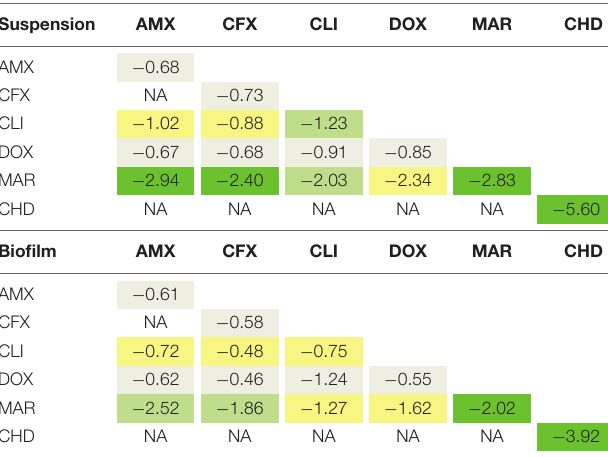
TABLE 2 | Bacterial reductions of S. aureus suspension (in log 10 CFU/mL) and biofilm (in log 10 CFU) after 15-h exposure to one drug or to a two-drug combination.